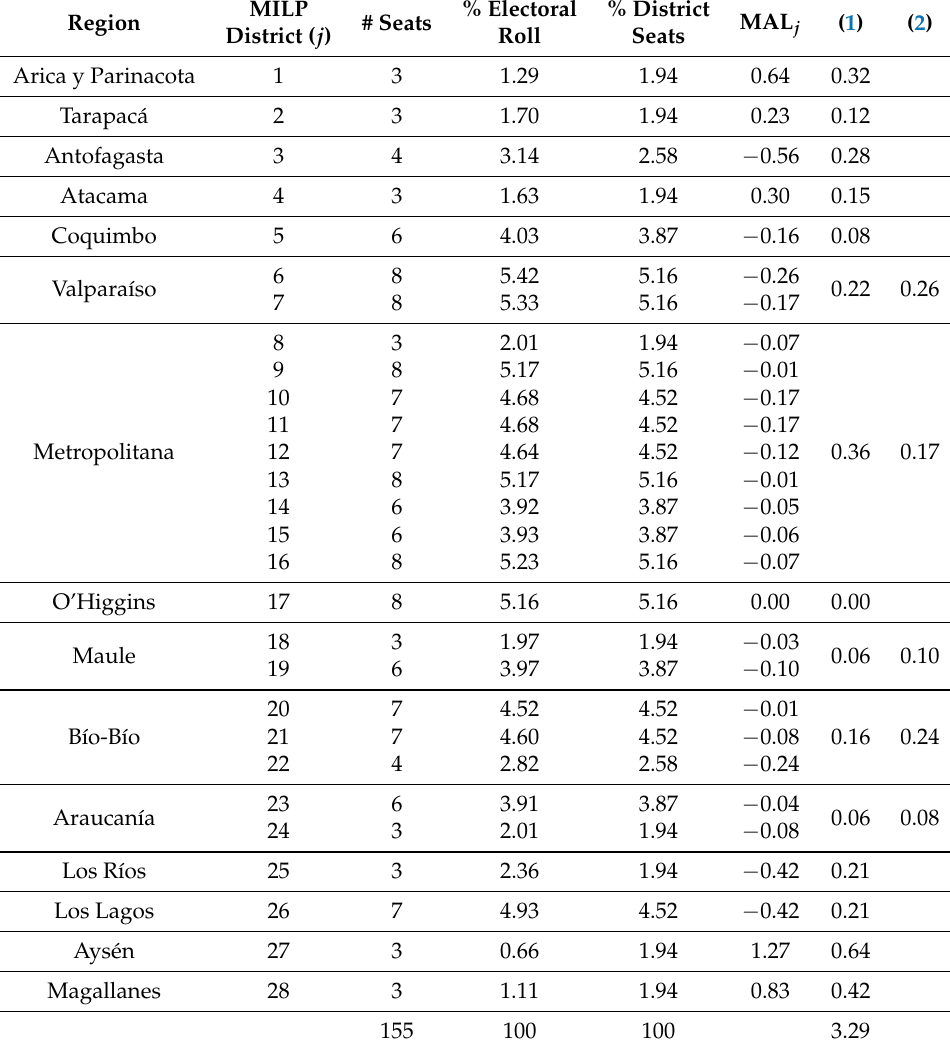
Table 3. Summary of the Chamber of Deputies electoral system obtained by solving (6)–(16).